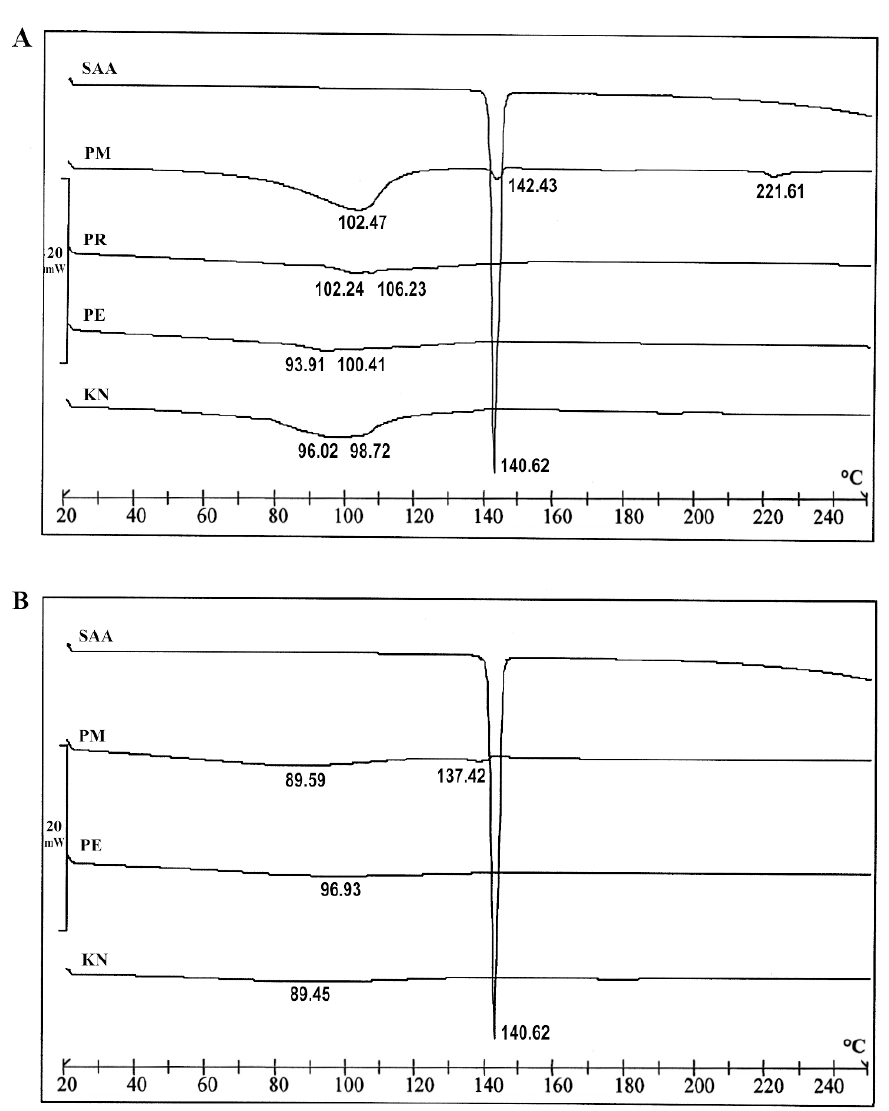
Figure 3. DSC scans of salicylamide (SAA), its physical mixtures (PM) and inclusion complexes (PR, PE, KN) with β -cyclodextrin (A) and 2-hydroxypropyl- β -cyclodextrin